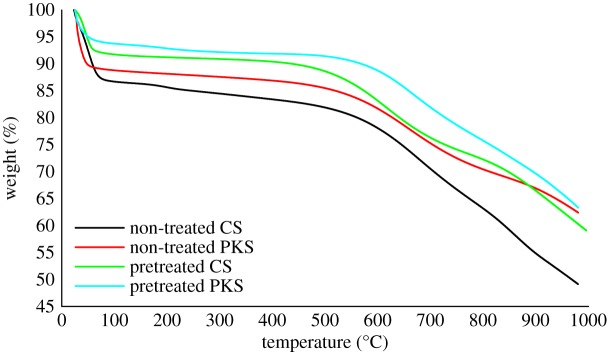
TGA for the non-treated CS and PKS bioadsorbent carbonized with temperature at 700°C for 75 min and CS and PKS bioadsorbent pretreated with H3PO4 with a temperature of 80°C under carbonization temperature at 700°C for 75 min.